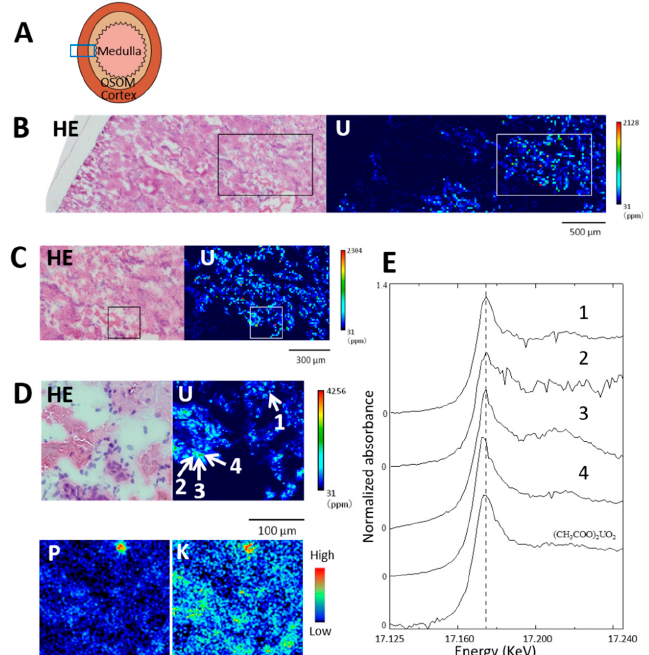
Figure 7. Uranium distribution in kidney and uranium LIII-edge XANES (X-ray absorption near edge structure) spectra of concentrated uranium in the S3 segments of the proximal tubule. Renal section on day 3 after administration of UA (2 mg kg − 1 ). ( A ) Analyzed area of renal specimen. ( B ) Uranium imaging (150 × 50 steps at 20 µ m per step; beam size, 1 µ m × 1 µ m). HE, hematoxylin and eosin. ( C ) High-resolution uranium imaging of boxed area in (B) (100 × 60 steps at 10 µ m per step; beam size, 1 µ m × 1 µ m). ( D ) High-resolution uranium (110 × 100 steps at 2 µ m per step; beam size 1 µ m × 1 µ m) and µ -PIXE imaging of phosphorus and potassium in boxed area in (C). Point 1, concentrated phosphorus; points 2, 3, and 4, without concentrated phosphorus. Uranium levels at points 1, 2, 3, and 4 were 2919, 938, 1980, and 2627 µ g g − 1 , respectively. The periphery of the renal cortex is on the left side of all images. Mean renal uranium concentration was 24.1 µ g g − 1 . ( E ) LIII-edge XANES spectra of concentrated uranium in the S3 segments of the proximal tubule; graphs 1, 2, 3, and 4 are for points 1, 2, 3, and 4 in panel ( D